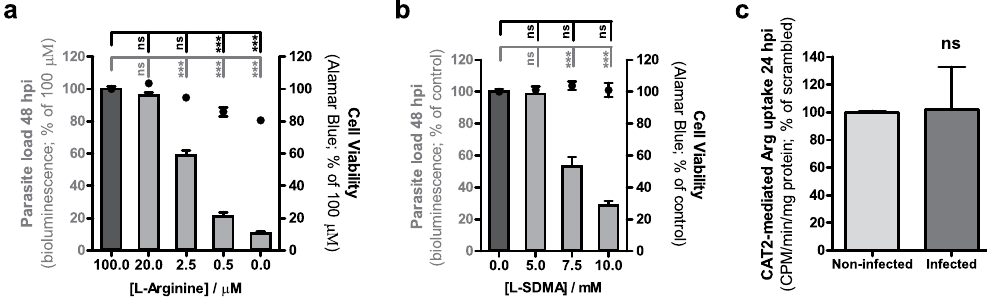
Figure 3. Arg uptake is essential for Plasmodium hepatic infection but CAT2A/B function is not increased in infected cells. Huh7 cells were infected with luciferase-expressing P . berghei sporozoites and cultured in medium with ( a ) decreasing concentrations of Arg or ( b ) increasing concentrations of the competitor L-SDMA. Parasite load (bioluminescence) and cell viability were assessed at 48 hpi. Pool of 3 independent experiments. Both panels: One-way ANOVA with post-test Dunnett. ( c ) CAT2A-mediated [ 3 H] Arg uptake by sorted P . berghei -infected cells and non-infected cells at 24 hpi. Pool of 2 independent experiments. Unpaired t-test. All panels: error bars represent SEM. ns - not significant and *** p <